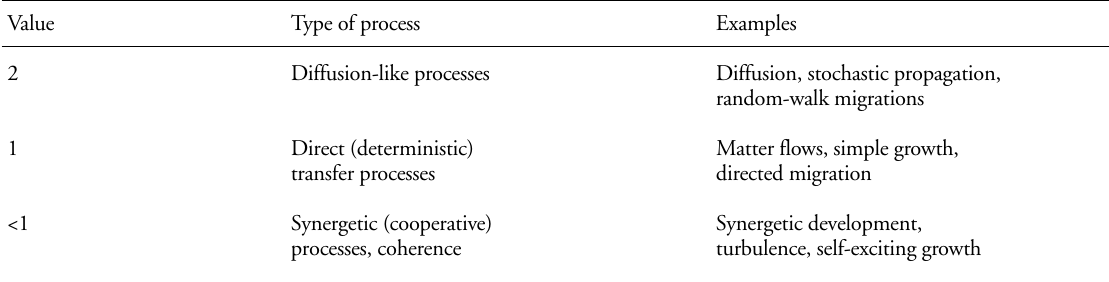
Table 2. Scaling parameter (time/space ratio) characteristic for pattern-generating processes of different nature.